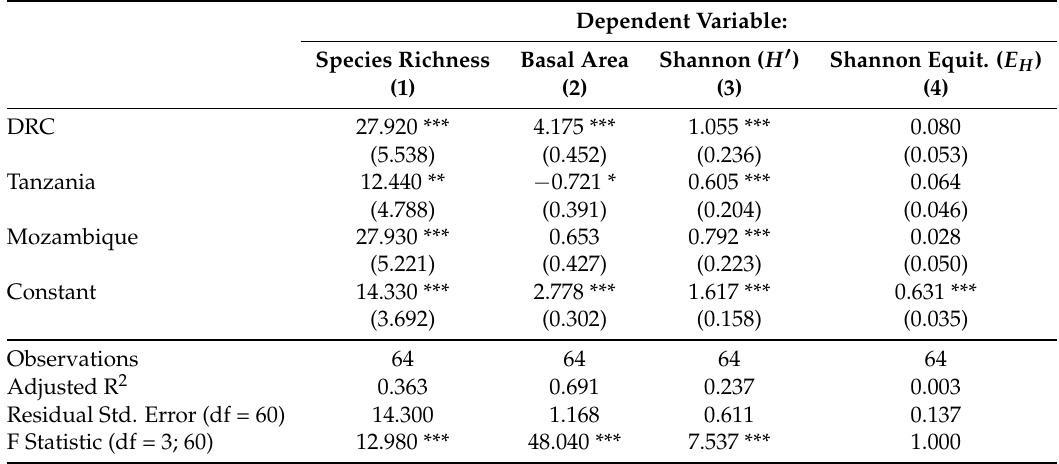
Figure 3. Variation of alpha diversity estimates and basal area among sites. Boxes bound the 1st and 3rd quartiles, with the median within the box. Whiskers represent 1.5 times the interquartile range plus or minus the 1st and 3rd quartiles, respectively. Values found beyond the whiskers are shown individually as points. Letter labels above each box refer to groupings from post-hoc Tukey’s tests on the ANOVA of each diversity/structure variable. Sites sharing a letter do not differ significantly ( p < 0.05). Table 3. Results of ANOVA tests for alpha diversity metrics and plot basal area, among the four sites. Mean values for each site with standard errors in parentheses are shown. Asterisks indicate the p -value of individual sites in each ANOVA (*** <0.001, ** <0.01, * <0.05, .